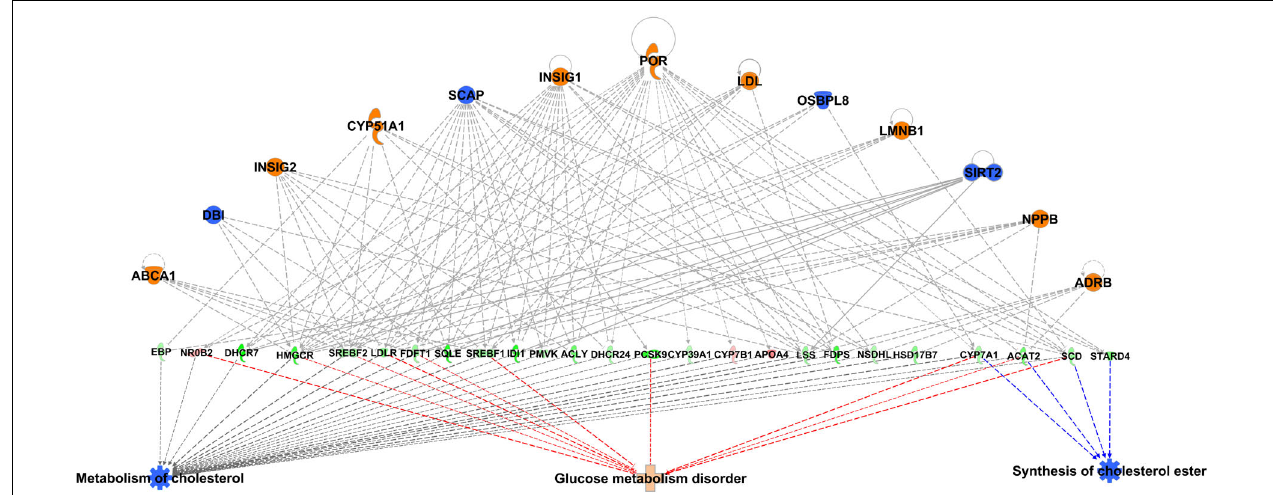
FIGURE 13 | Mechanistic network summarizing main effects of maternal HSD programming effect on activation (shades of orange) or inhibition (shades of blue) of upstream regulators in white adipose tissue, liver, and brown adipose tissue in male offspring of HSD- vs. standard diet-fed rat dams of SHR and SHR- Zbtb16 rat strains. The programming effect on the expression of genes significantly differentially expressed in the above datasets is shown in shades of green (downregulation) or red (upregulation). Derivation of the network was performed using Ingenuity Pathways Analysis.